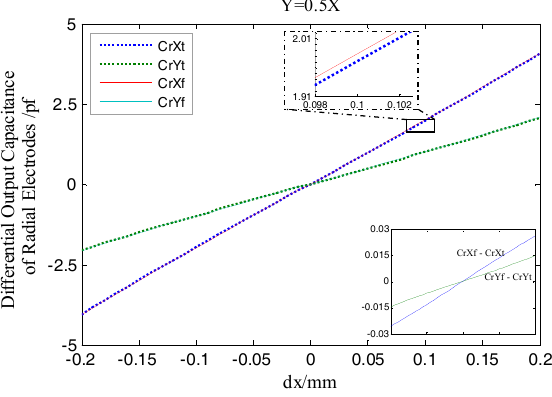
Figure 12. Simulation and theoretical results comparison of radial differential output capacitance.